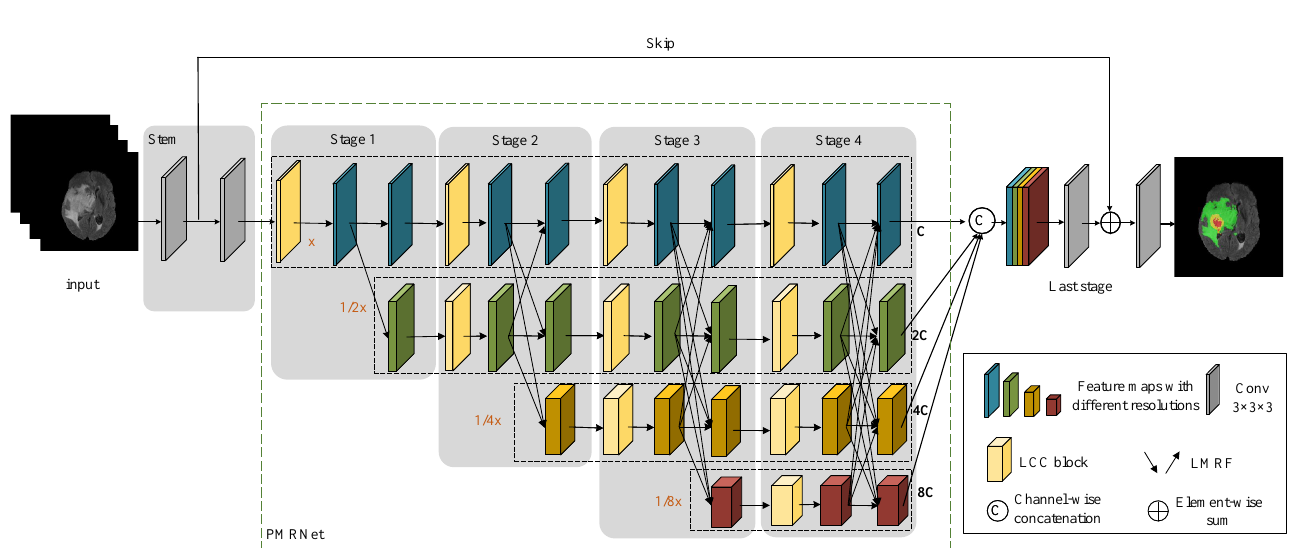
Figure 1. The architecture of our proposed HMNet. x denotes the input resolution, and C denotes the channel number of feature maps. We design a backbone network (PMRNet), which contains a high-resolution branch and parallel multi-resolution branches. The high-resolution branch can maintain the spatial details of the brain tumor. Meanwhile, multi-resolution feature exchange and fusion enables the receptive fields of the network to adapt to brain tumors with different sizes and shapes. In PMRNet, we propose a lightweight conditional channel weighting (LCC) block and a lightweight multi-resolution fusion (LMRF) module to overcome the large computational overhead caused by expensive 3D convolution and the fusion